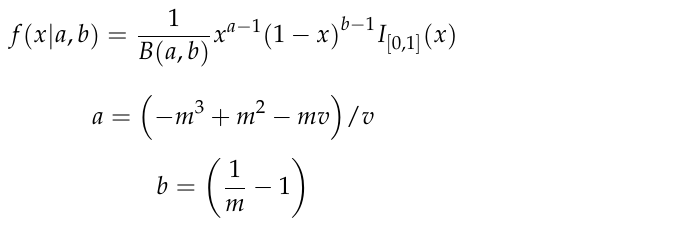
Figure 7. Probability density distribution of CAPEX.